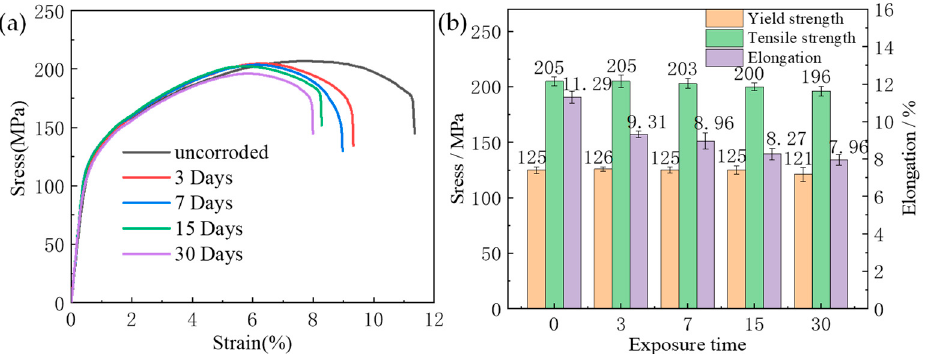
Figure 2. Mechanical properties and stress–strain curves of the 5083/6005a welded joints after corrosion in the 3.5% NaCl + 0.01 mol /L NaHSO 3 solution for different times: ( a ) stress–strain curve; ( b ) mechanical properties.